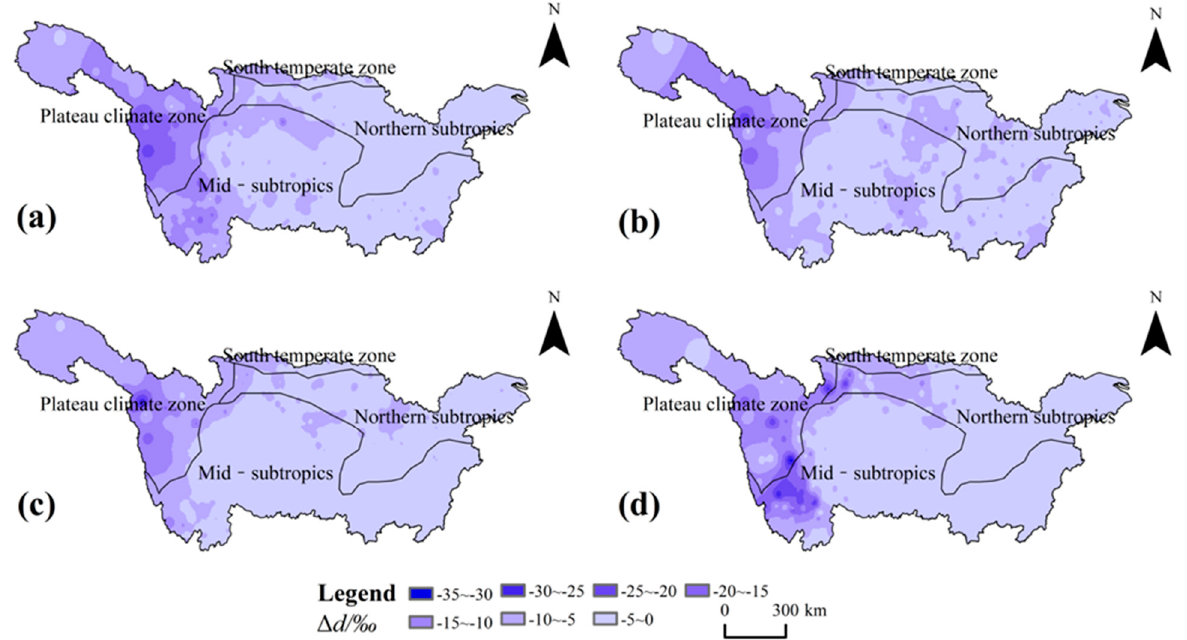
Figure 4. Spatial variation of Δ d value in different seasons in the Yangtze River basin: ( a ) spring, ( b ) summer, ( c ) autumn, and ( d ) winter.